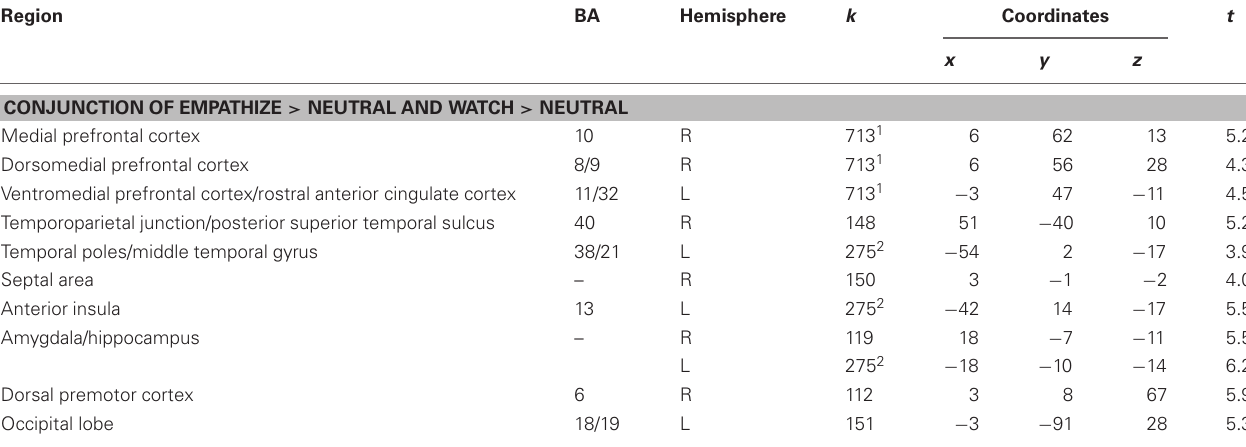
Table 3 | Neural regions that were commonly activated during empathize and watch (collapsed across happiness, sadness, and anxiety) compared to